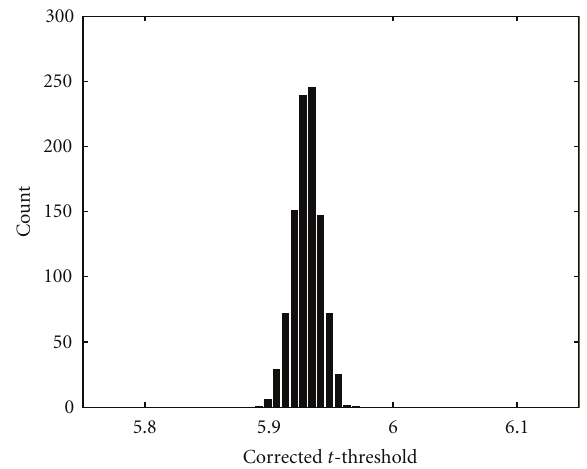
Figure 13: The distribution of the corrected t -threshold when 10000 permutations were